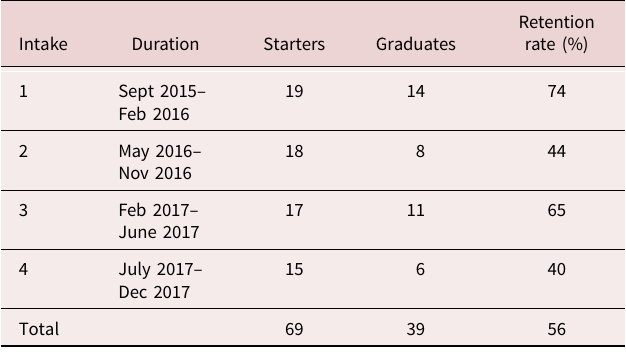
Table 1. Key Brewarrina campaign